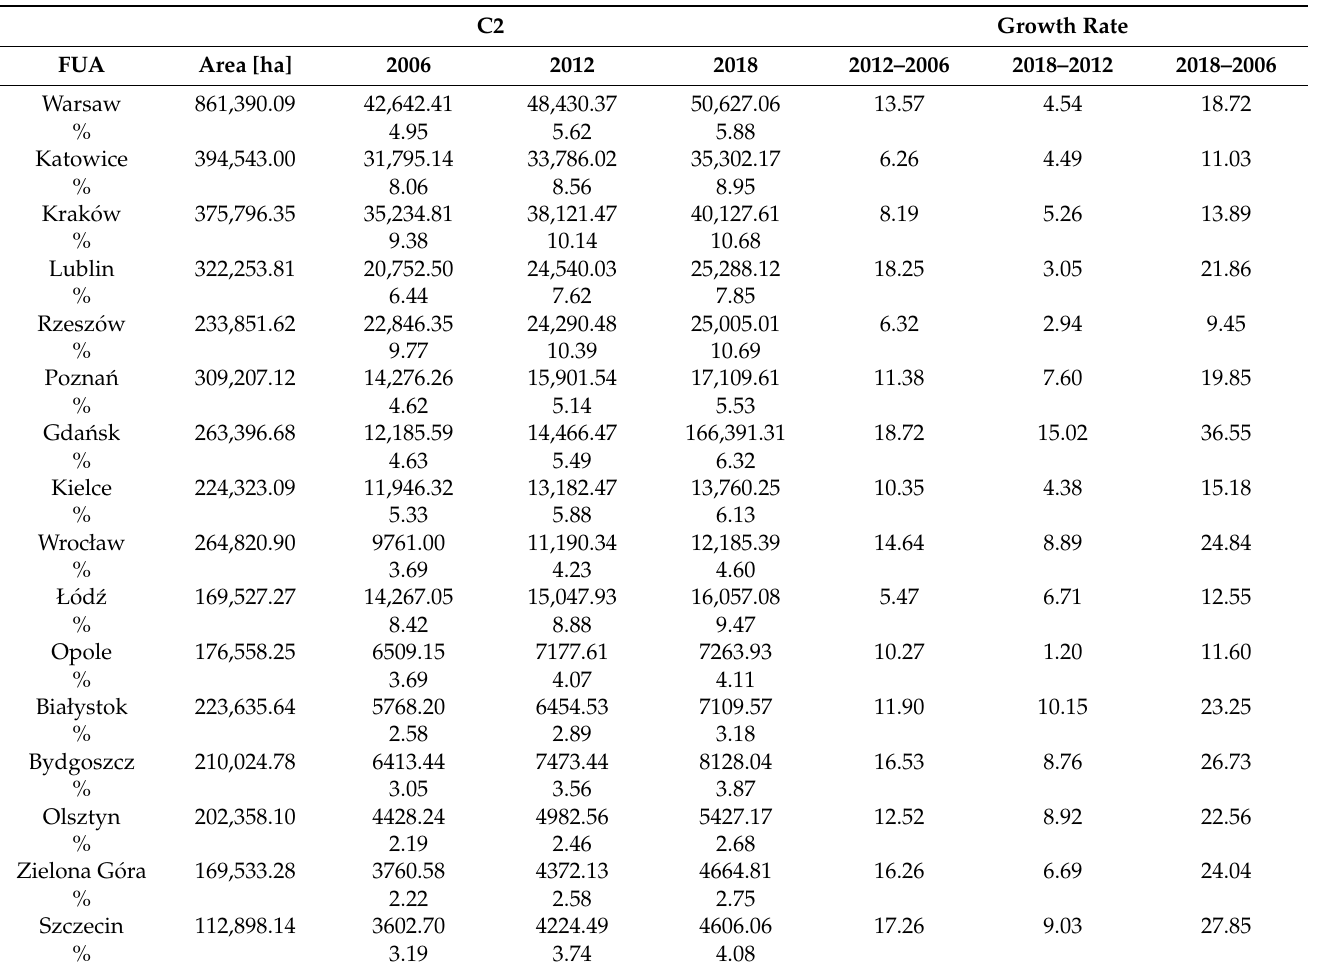
Table 4. C2 area [ha] in each investigated area in 2006, 2012, and 2018. C2 Growth